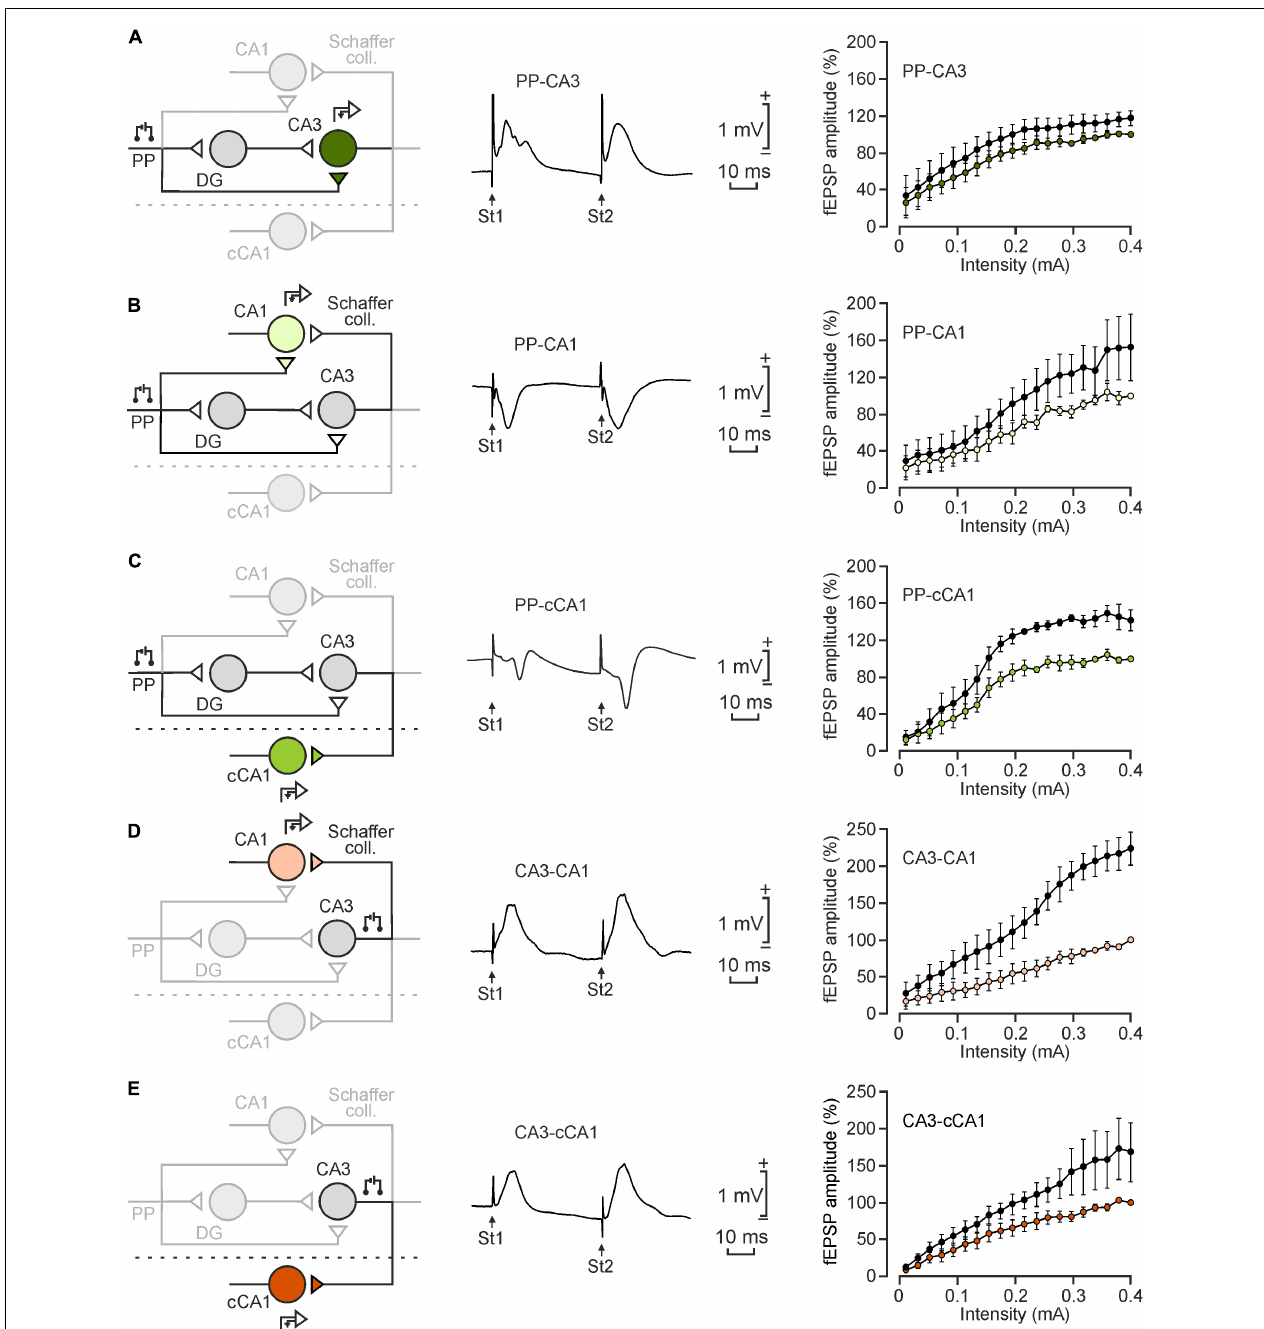
FIGURE 2 | Input/output curves of the five selected synapses. (A–E) From left to right are illustrated a schematic representation of the synapse under study, a representative example of the fEPSP recording at 2 × Threshold intensities (St1: first stimulus; St2: second stimulus) and input/output curves collected from the five illustrated synapses: (A) , PP-CA3; (B) , PP-CA1; (C) , PP-cCA1; (D) , CA3-CA1; and (E) , CA3-cCA1. Computed curves were normalized as the percentage of amplitude values reached under the maximum intensity. Black circles stand for the second stimulus. Data were collected from 5 animals/synapse.